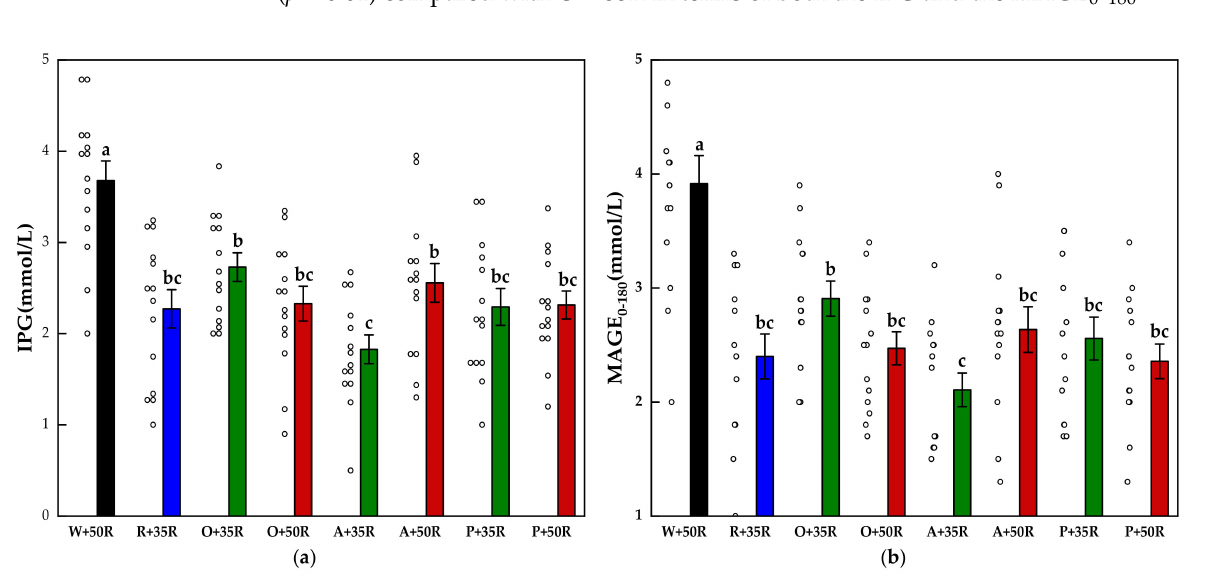
Figure 4. ( a ) IPG, ( b ) MAGE 0–180 for test meals. The hollow circles indicate the data of each subject, the columns indicate the mean value, the error bar indicates the SE value. Significant differences ( p < 0.05) are represented by different letters.